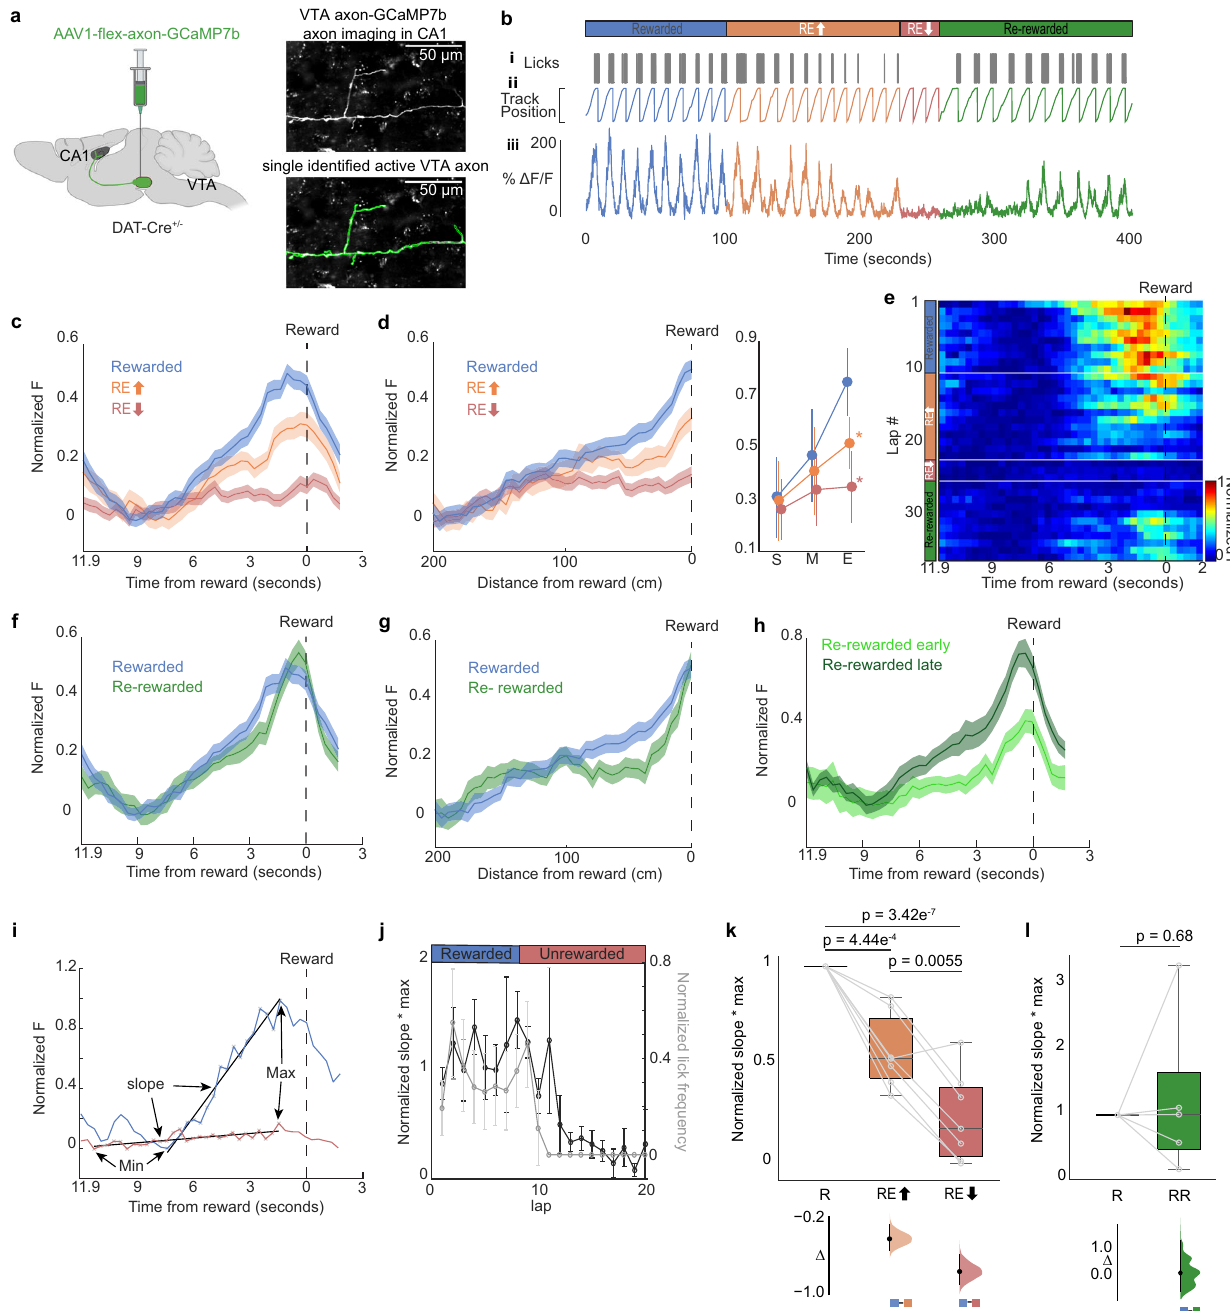
Fig. 5 | Activity of dopaminergic VTA axons in CA1 ramp up to reward. a Schematic representation of injection procedure created with BioRender.com (left). Example CA1 fi eld of view of VTA axons (right, top). Extracted region of interest (right, bottom). b Example mouse. i: Mouse licking behavior. ii: Mouse track position. iii: Δ F/F from an example ROI. c Fluorescent activity of axons (7 axons in 6 mice) in R (blue), RE high (orange-RE arrow), and RE low (red-RE arrow) experimentalconditionsaveragedbytimetoreward.Shadedareasrepresents.e.m. d Same data, averaged by position (left). Mean with 95% CI (error bar) of starting 50cm (S), middle 100cm (M), and end 50cm (E)(right). Asterisk (*) indicates sig- ni fi cant p-values (two-sided paired t test, P <0.01) obtained by comparing R (blue) withothertasksateachposition. e Normalized fl uorescenceofanexampleaxonin the different conditions binned by time to reward. White lines divide each condition, and the dashed line represents time of reward delivery. f Fluorescent